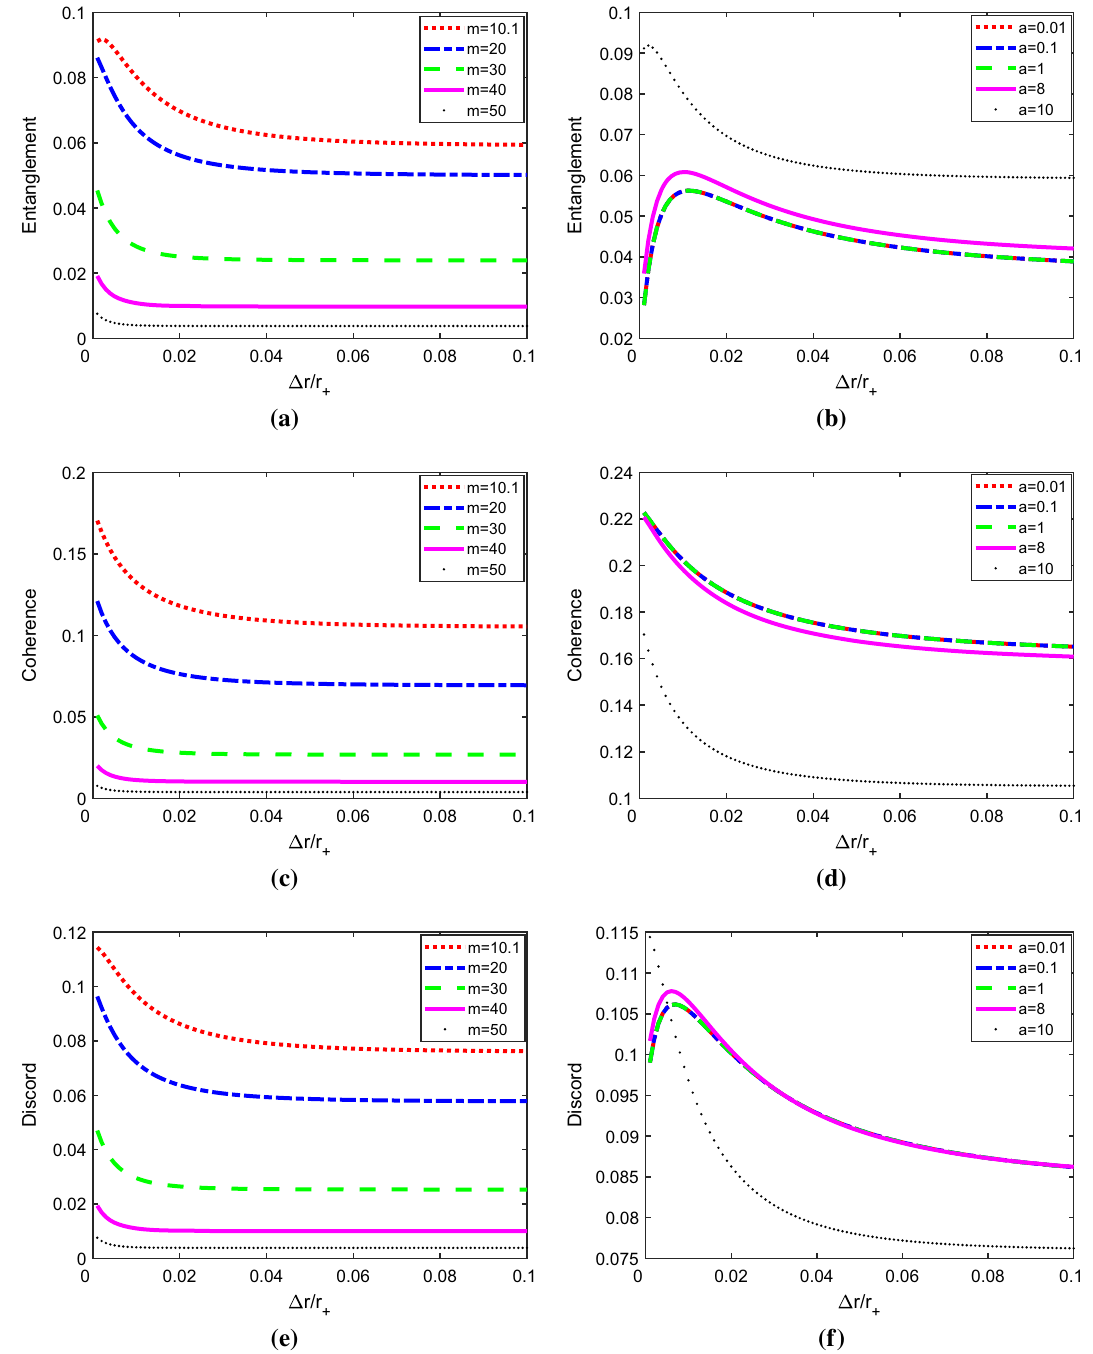
Fig. 12 We consider a nonequilibrium scenario: one of the two atoms is stationary at 1 . 006 r + , while another is at ( 1 . 006 + (cid:2) r ) r + . Quantum correlations at nonequilibrium steady state vary with the separation distance for a = 10 or M =